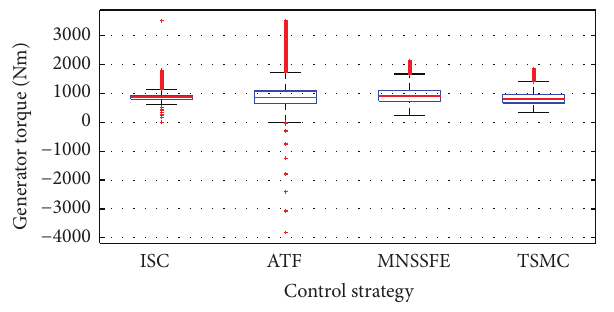
Figure 10: Box plot for generator torque using FAST simulator.